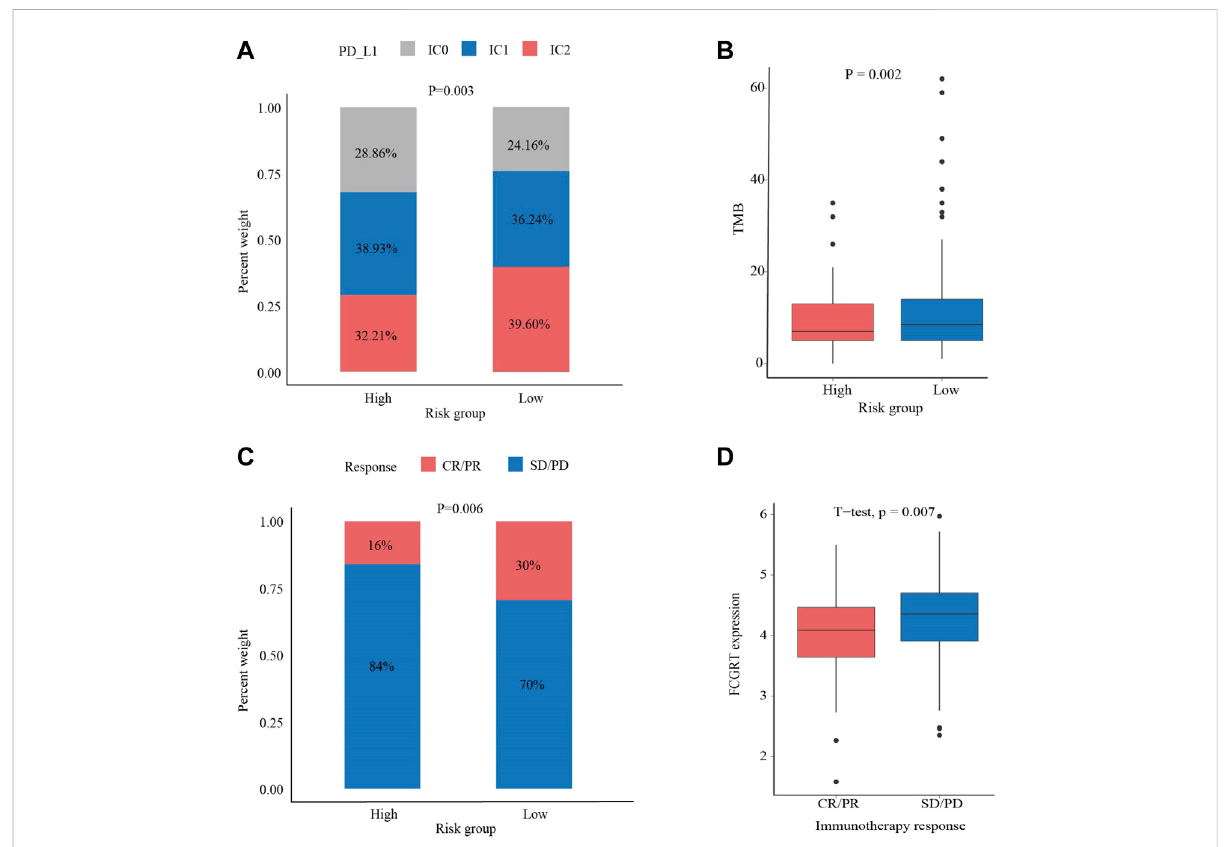
The correlation between FCGRT expression and response to immunotherapy (A,B) The correlation between FCGRT expression and PD-L1 and TMB level ( p = 0.03, p = 0.002) (C,D) The correlation between FCGRT expression and immunotherapy sensitivity ( p = 0.06, p =